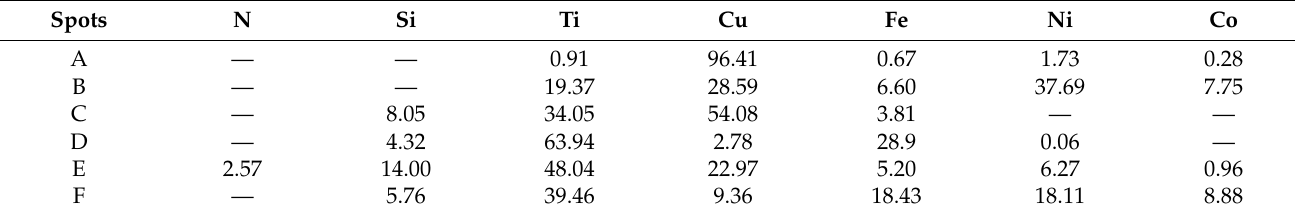
Table 5. Component content of each point in Figure 10